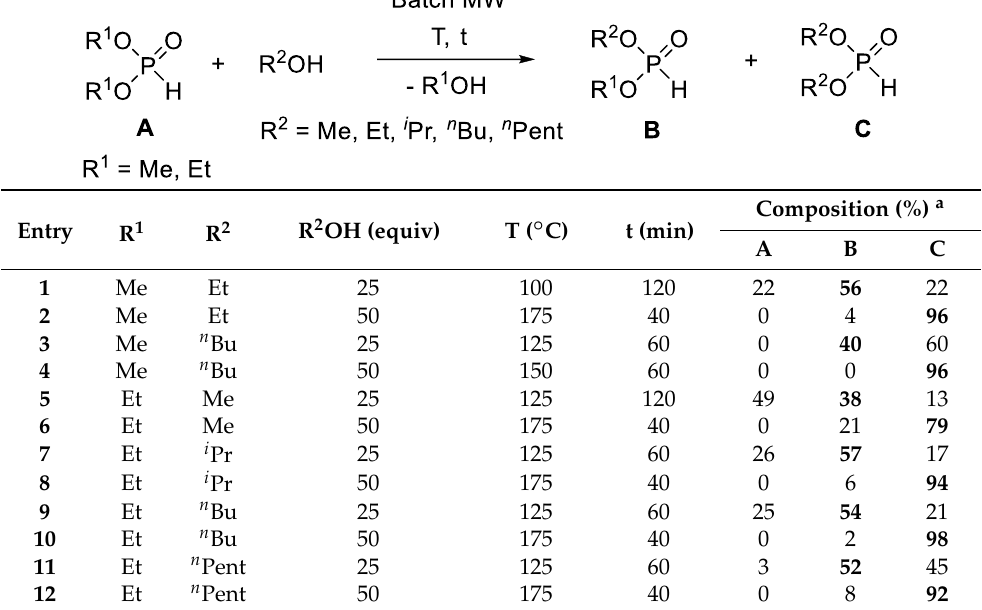
a Analyzed by GC. Bold numbers indicate the target compounds in the